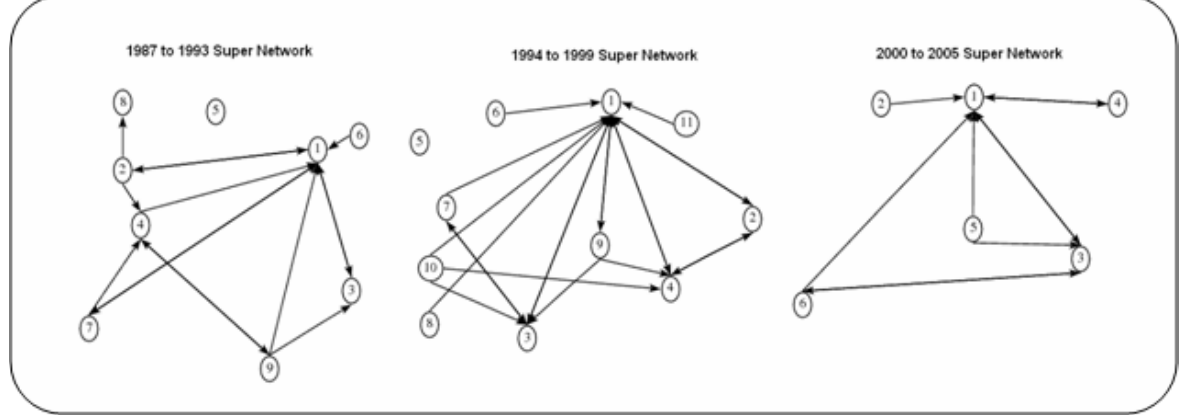
Figure 8 . Super networks for abstracts by time